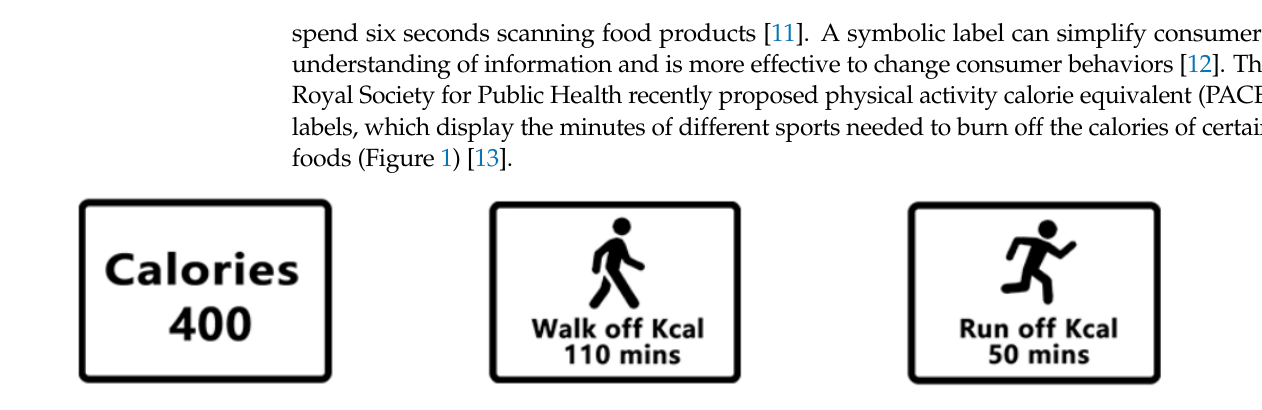
Figure 1. The examples of PACE labels (400 kcal).